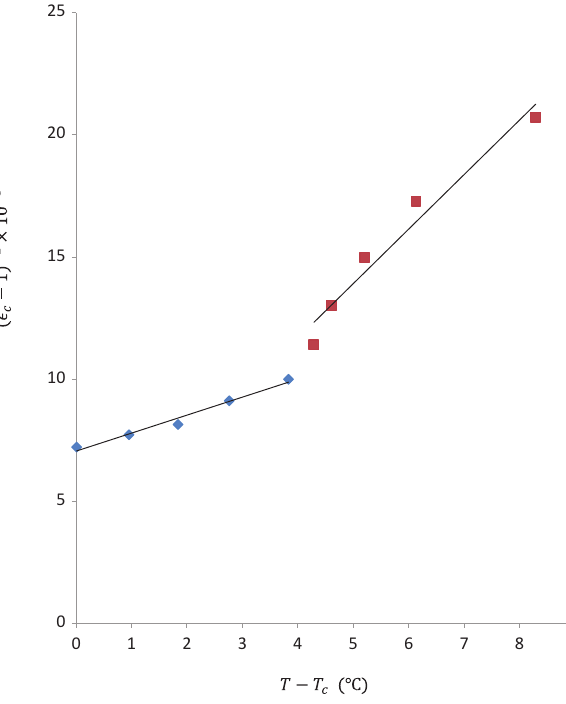
Figure 1: The reciprocal dielectric constant ε c as a function of T − T c in the paraelectric ( T > T c ) phase of TMAHSO 4 in the two temperature intervals indicated. Solid line represents the fit of eq. (16) to the observed data [1] (See Table 1).